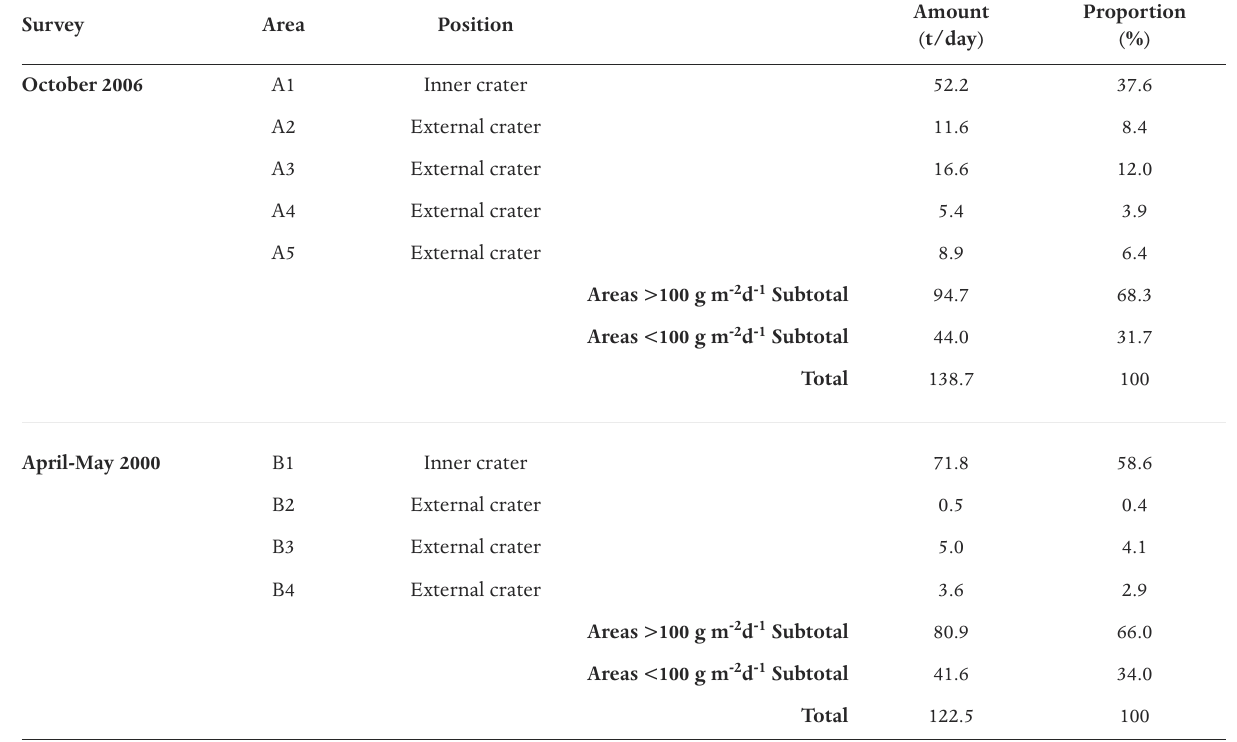
emission of Vesuvio 2